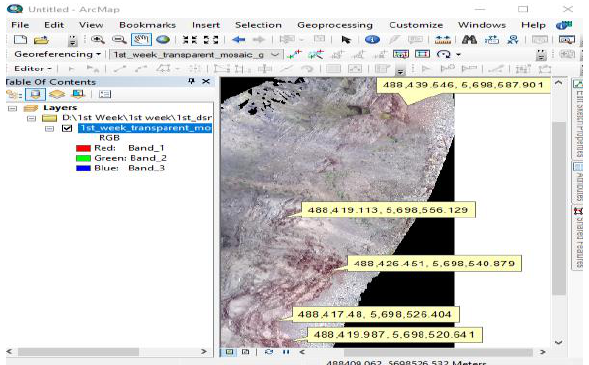
Figure 11. Verification of the CloudCompare Global Coordinates in